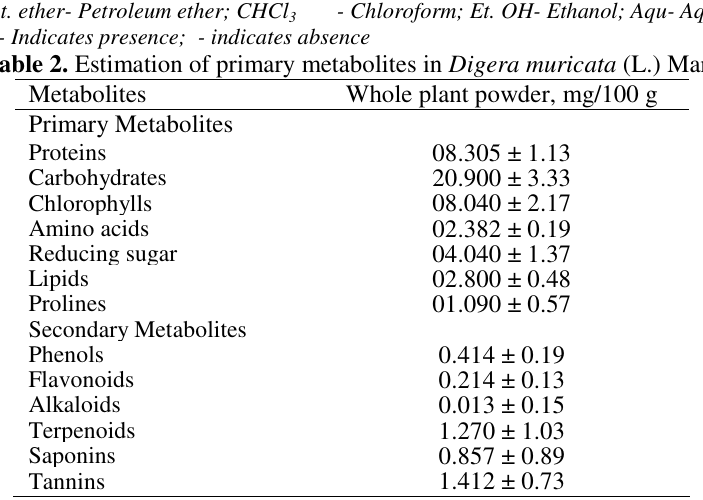
Table 2. Estimation of primary metabolites in Digera muricata (L.) Mart